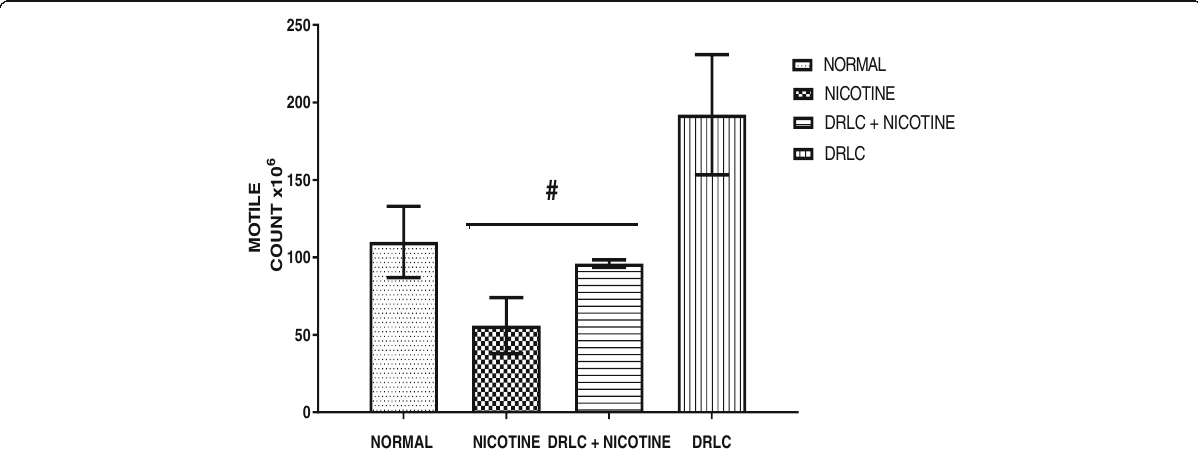
Fig. 8 Chart showing the motile sperm count of the experimental animals. Values are mean ± SEM. N = 5. # Statistically different from normal control and DRLC groups at p < 0.05